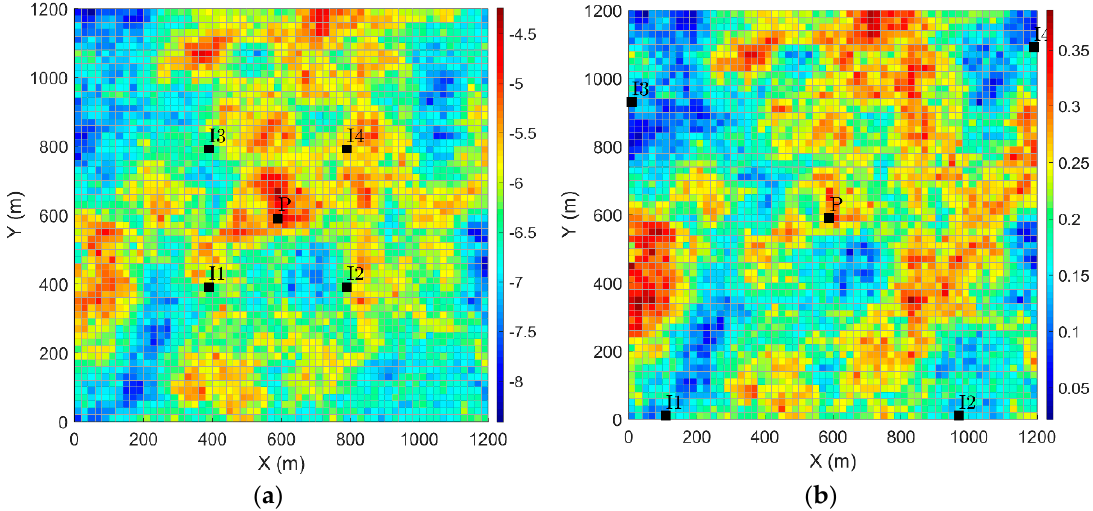
Figure 6. Distributions of (a) the hydraulic conductivity in Log 10 scale and (b) the effective porosity for the two-dimensional heterogeneous aquifer. ( a ) Initial and ( b ) optimal positions of the injection wells are also shown.